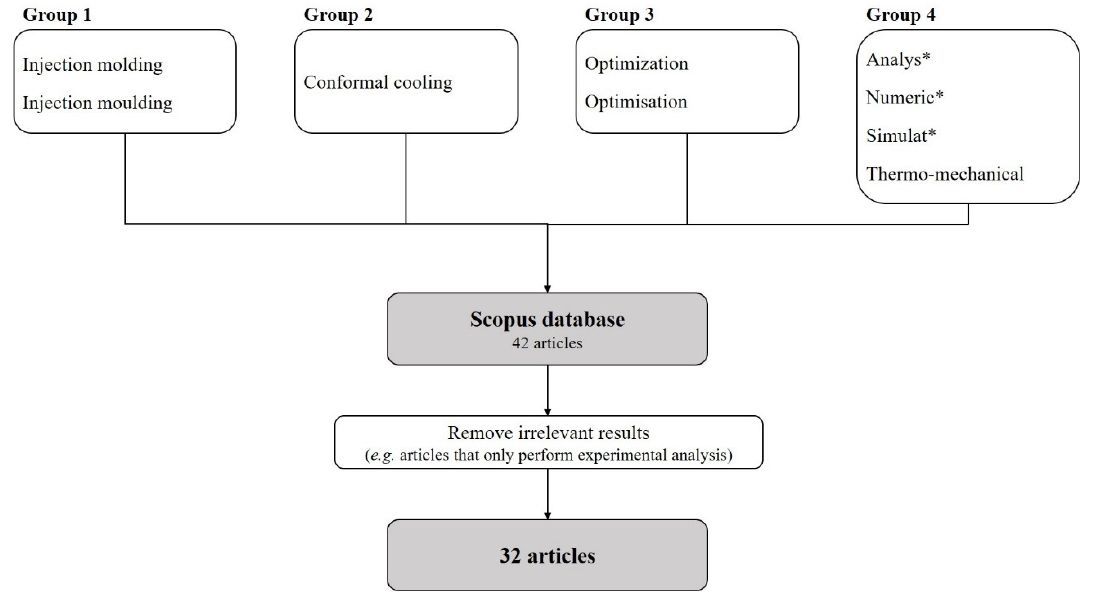
Figure 2. Structure and search terms used for the literature search, where the * stands for any random characters.